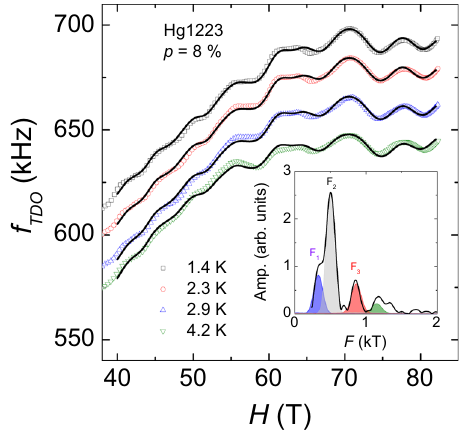
Table 1 Sample family, T c , doping p and QO frequency deduced from the discrete Fourier transform analysis.